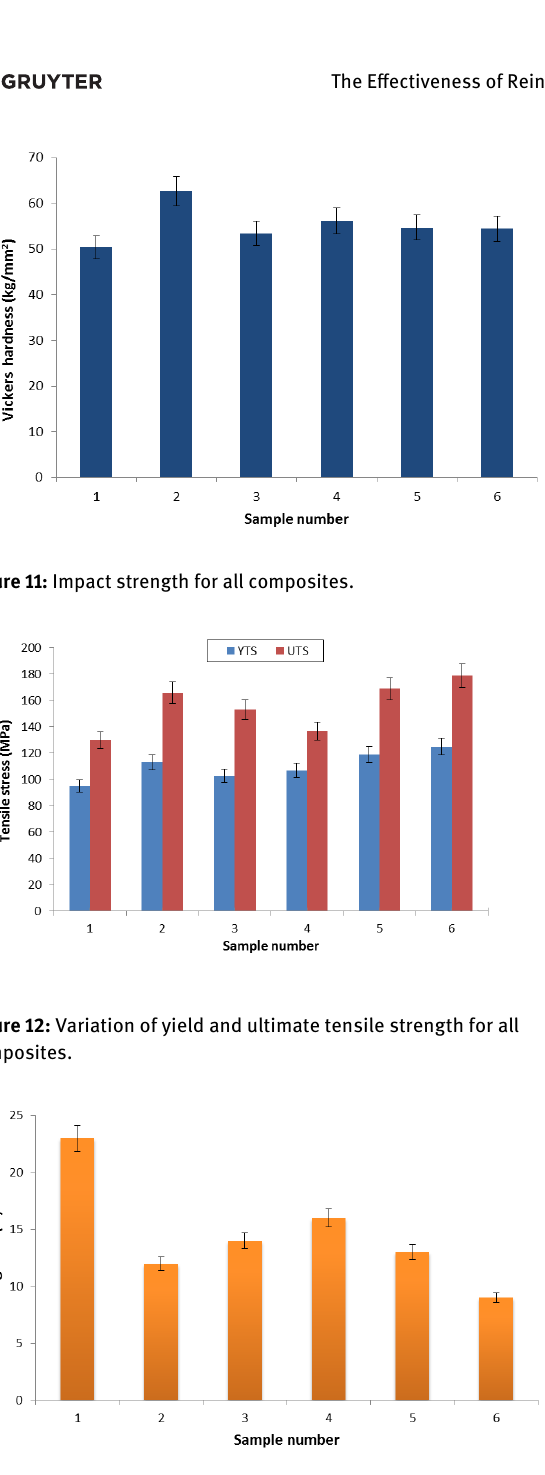
Figure 13: Variation of elongation for all